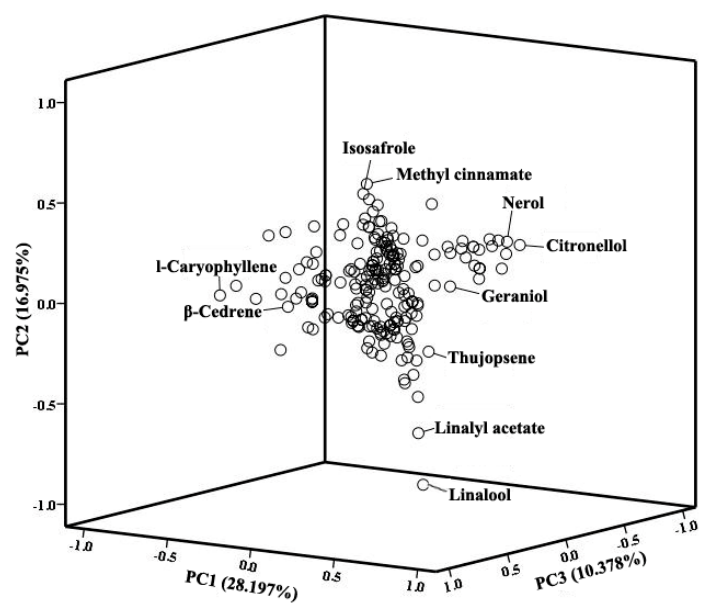
Figure 1. 3D loading plot of Eigenvector load values for 219 floral scent components from PC1, PC2 and PC3.